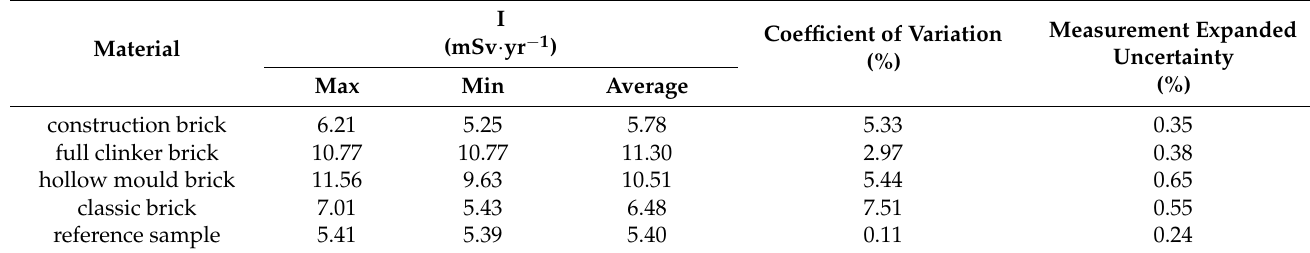
Table 2. Radioactivity concentration index measured for bricks.